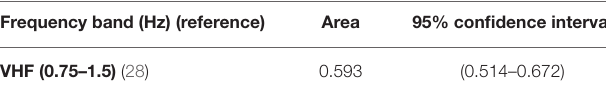
TABLE 2 | Area under ROC curve and correspondent non-parametric confidence interval, for the bands significantly different between groups of fetal acidemia defined with pH cutoff of 7.20, in the CTU-UHB open-access database (section Spectral Analysis on CTG Intrapartum Open-Access Database). Frequency band (Hz) (reference) Area 95% confidence interval